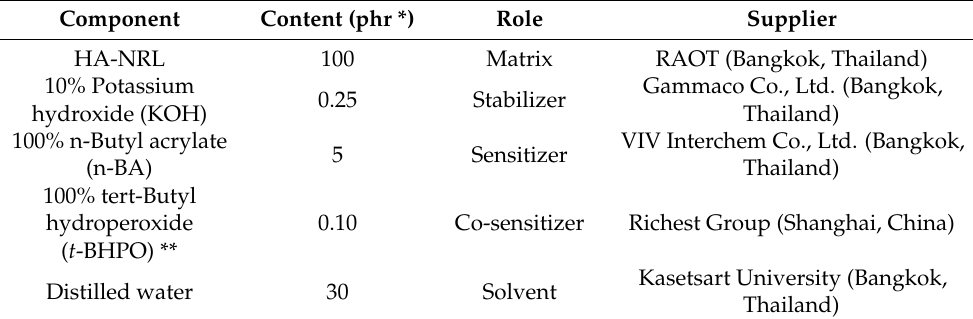
Table 2. Components of natural rubber latex (NRL) used during gamma irradiation for the fabrication of radiation-vulcanized natural rubber latex (R-VNRL) and hybrid radiation and peroxide-vulcanized natural rubber latex (RP-VNRL) composites and their roles and suppliers.